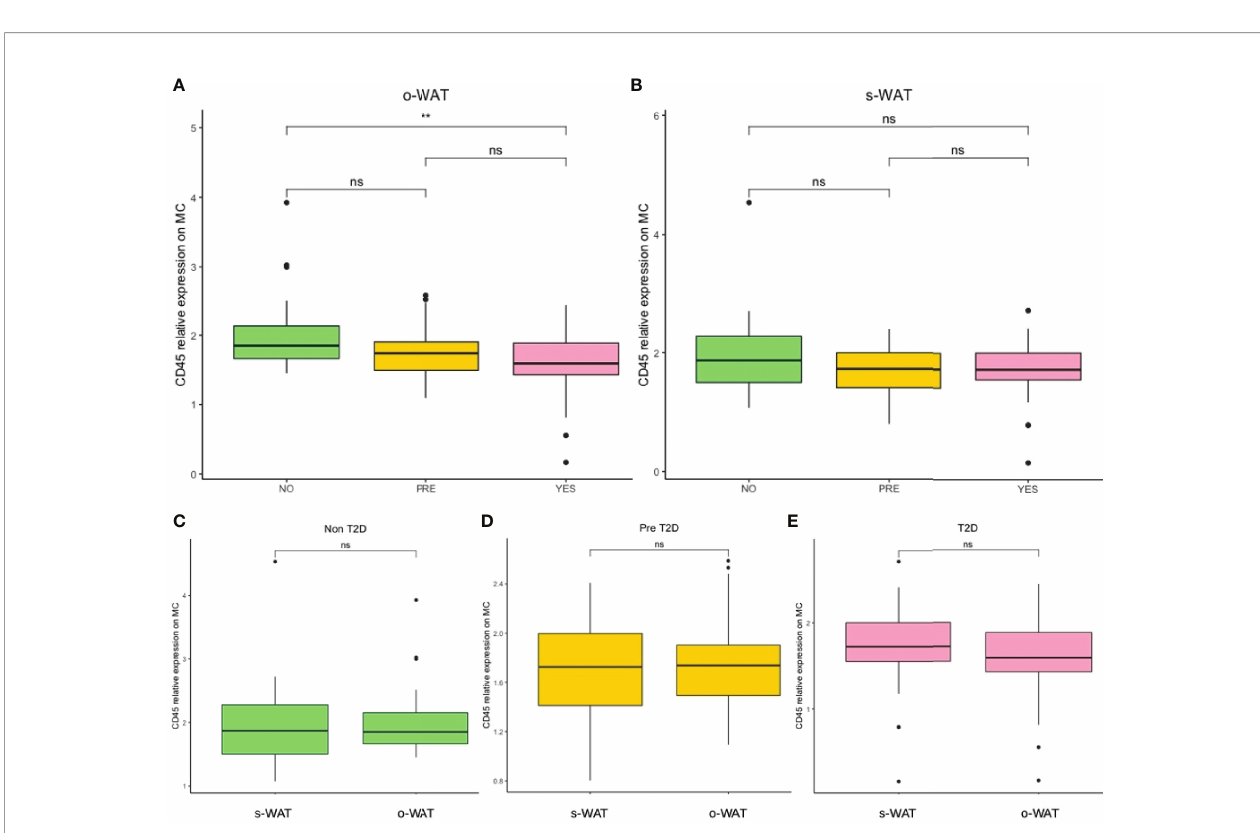
FIGURE 2 | Relative surface expression of CD45 on mast cells. (A) Comparison in o-WAT between the three groups. (B) Comparison in s-WAT between the three groups. (C) Comparison between o-WAT and s-WAT in the non-T2D group. (D) Comparison between o-WAT and s-WAT in the pre-T2D group. (E) Comparison between o-WAT and s-WAT in the T2D group. MC (mast cells), s-WAT (subcutaneous white adipose tissue), o-WAT (omental white adipose tissue), NO (non-type 2 diabetes group), PRE (pre type 2 diabetes group), YES (type 2 diabetes group), T2D (type 2 diabetes), n=96. ** (0.01 > p value > 0.001). “ ns ” means not signi fi cant.